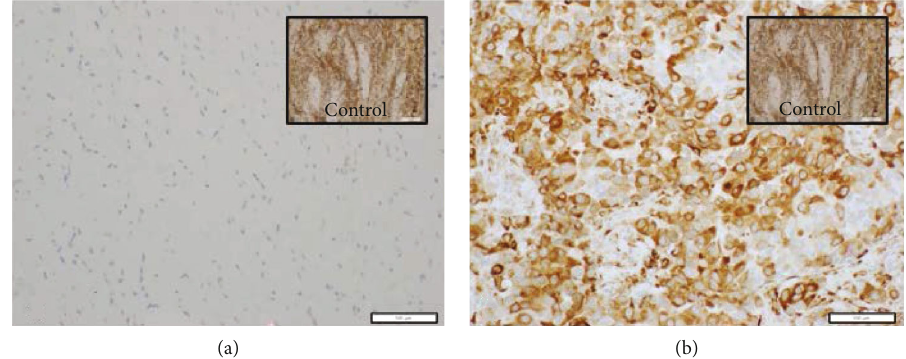
Figure 3: p-S6K1 IHC results (20x for both tumors, 10x for controls): (a) p-S6K1 negative ILC tumor with positive control; (b) p-S6K1 positive PILC tumor tissue with positive